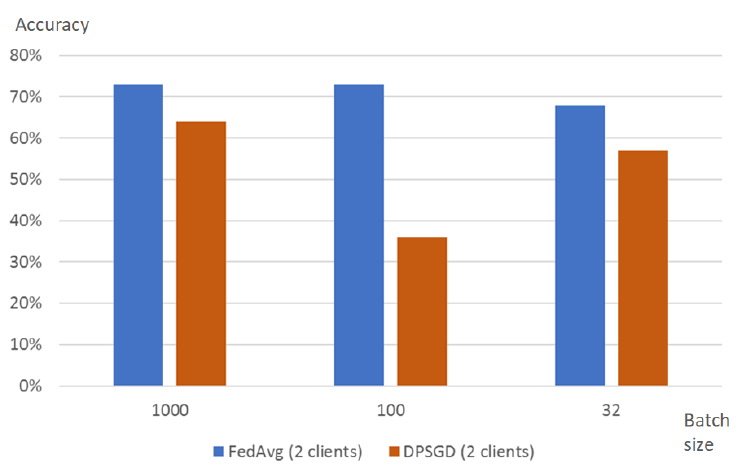
Figure 9. Accuracy of DPSGD strategy for two clients and round number set to